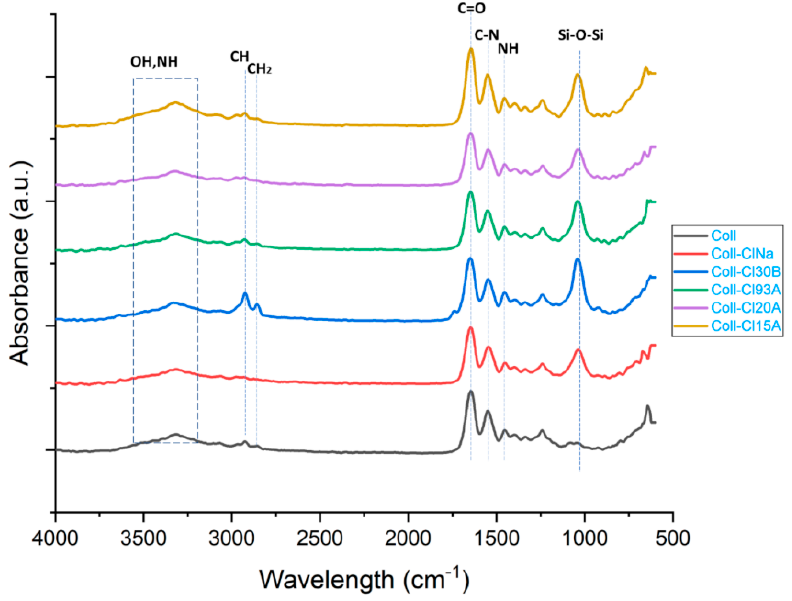
Figure 1. FTIR spectra of the obtained collagen/clay composite biomaterials.